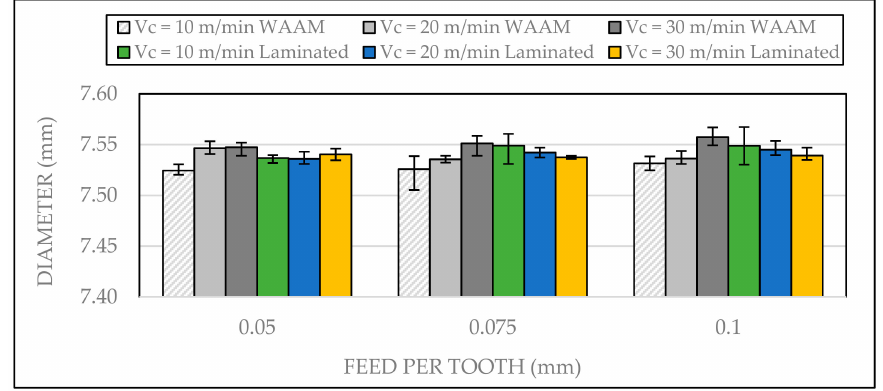
Figure 13. E ff ect of the cutting parameters and material manufacturing process on hole diameter.